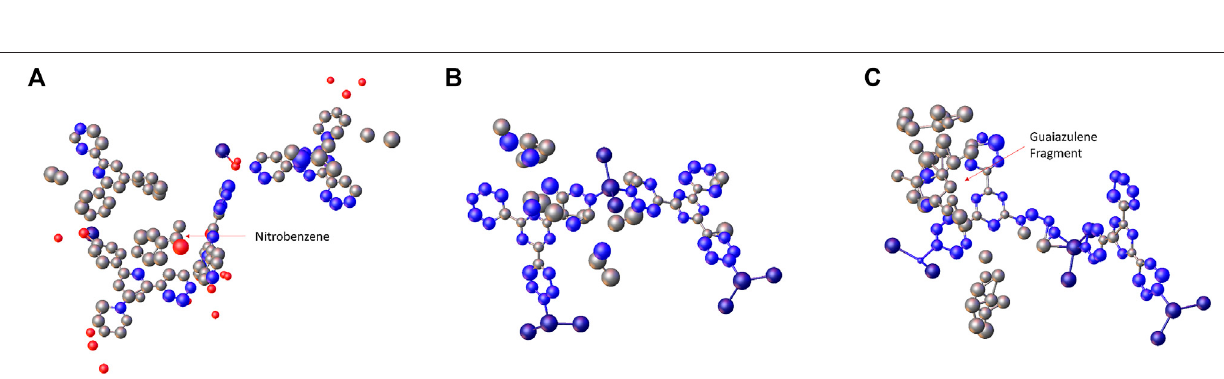
Frontiers in Molecular Biosciences |